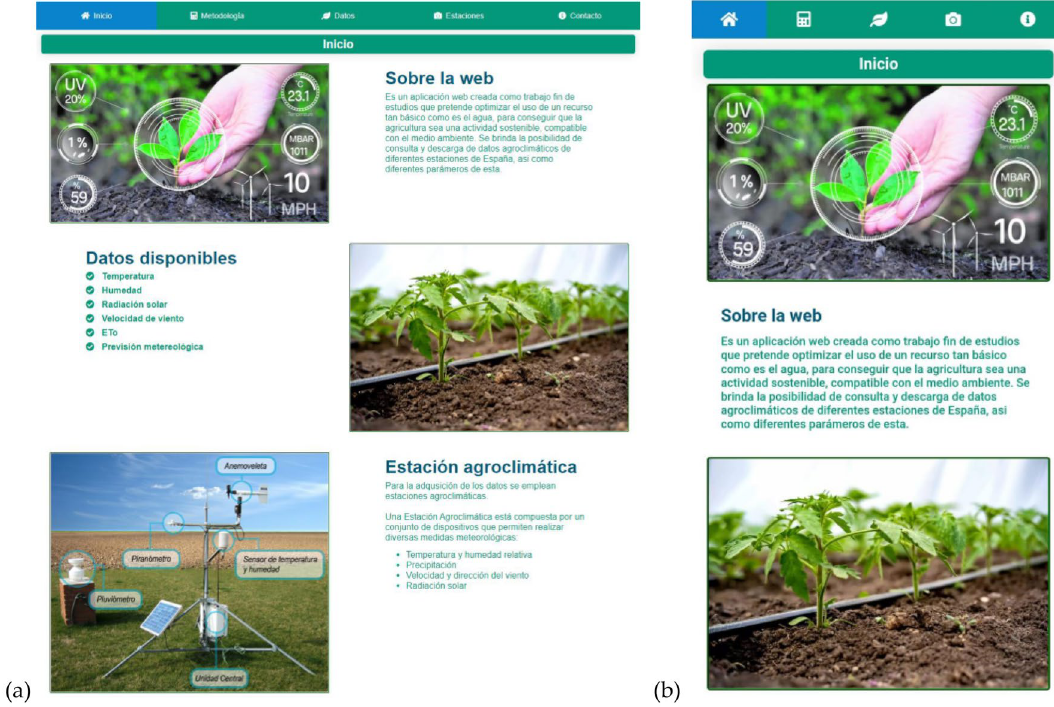
Figure 2. View of the initial tab in ( a ) the web application and ( b ) the mobile device.